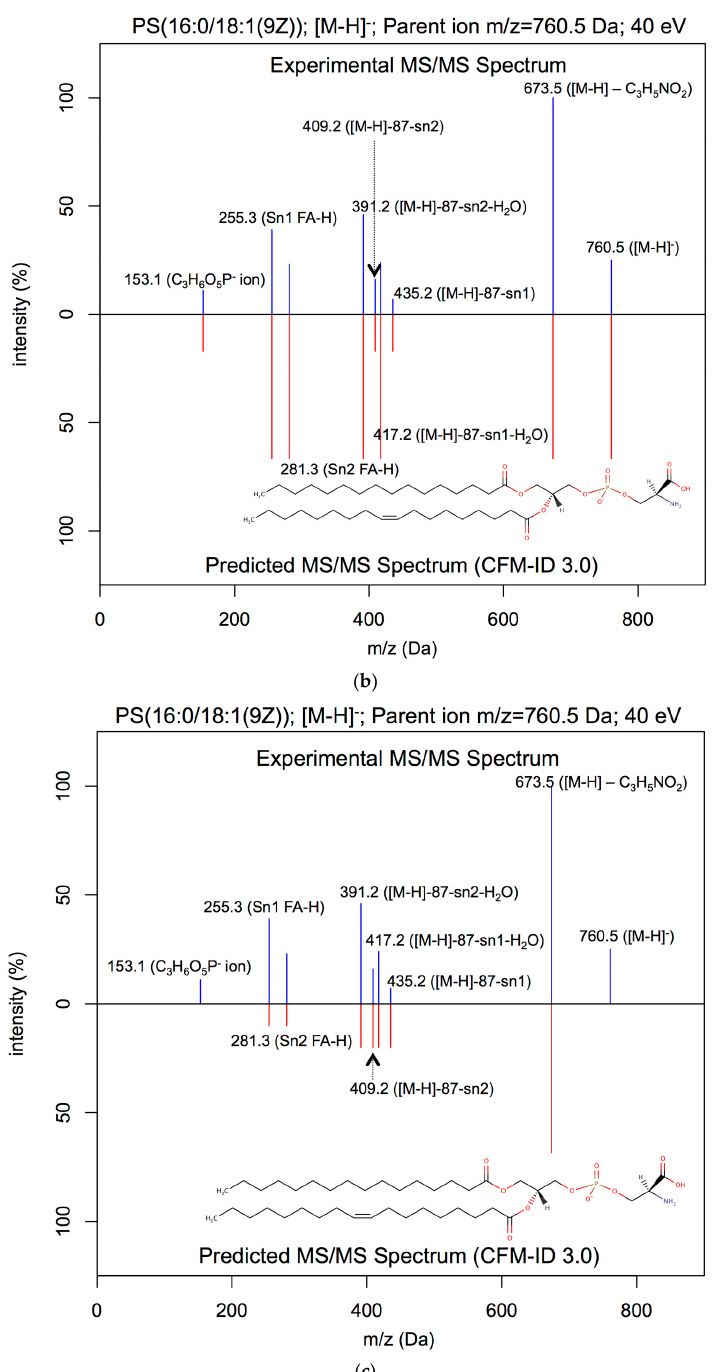
Figure 3. Head-to-tail plot of experimental and predicted ESI-MS / MS spectra of (PS(16:0 / 18:1(9Z))). ( a ) Head-to-tail plot showing an experimental of ESI-MS / MS spectrum of 1-palmitoyl-2-oleoyl- sn-glycero-3-phospho-L-serine (PS(16:0 / 18:1(9Z))) measured at 40 eV, and the matching ESI-MS / MS spectrum predicted by CFM-ID 2.0. The computed spectral similarity score is 0.10. ( b ) Head-to-tail plot showing an experimental ESI-MS / MS spectrum of 1-palmitoyl-2-oleoyl-sn- glycero-3-phospho-L-serine (PS(16:0 / 18:1(9Z))) measured at 40 eV, and the matching ESI-MS / MS spectrum predicted by CFM-ID 3.0. The computed similarity score is 0.92. ( c ) Head-to-tail plot showing an experimental ESI-MS / MS spectrum of 1-palmitoyl-2-oleoyl-sn-glycero-3-phospho-L-serine (PS(16:0 / 18:1(9Z))) measured at 40 eV, and the matching ESI-MS / MS spectrum predicted by LipidBlast. The computed similarity score is